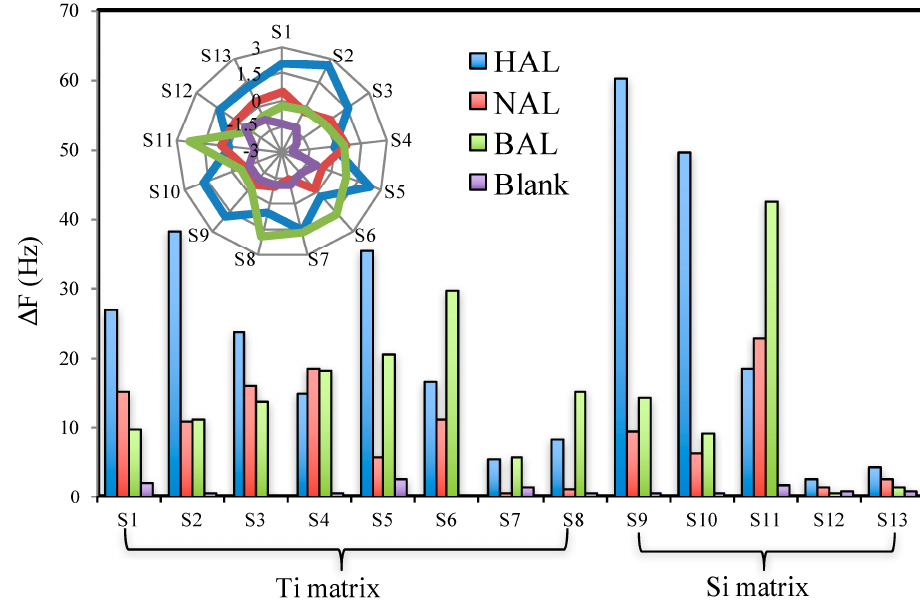
Figure 4. Response pattern of a 13 MISGs-coated sensor array on the three aldehydes and a blank. The vapors were generated with a flow rate of 0.3 L/min and the response of each channel was not normalized by the coating amount. Inset is a scaled radar chart of the 13 sensor channels.